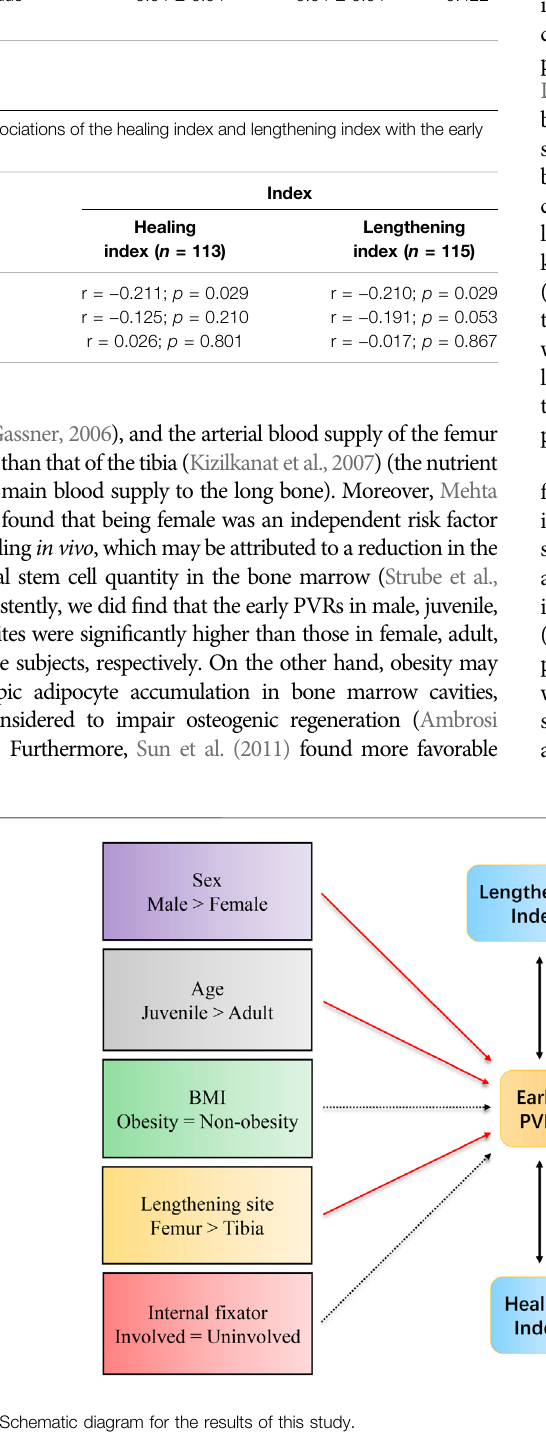
FIGURE 4 | Schematic diagram for the results of this